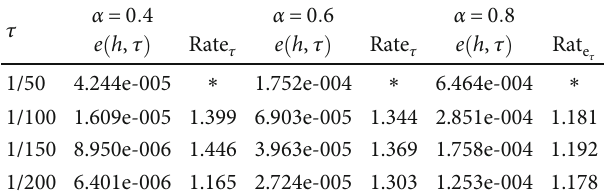
Table 1: Simulation results of Example 10, where h = 1/2000 and α = 0 : 4,0 : 6,0 : 8 . α = 0 : τ